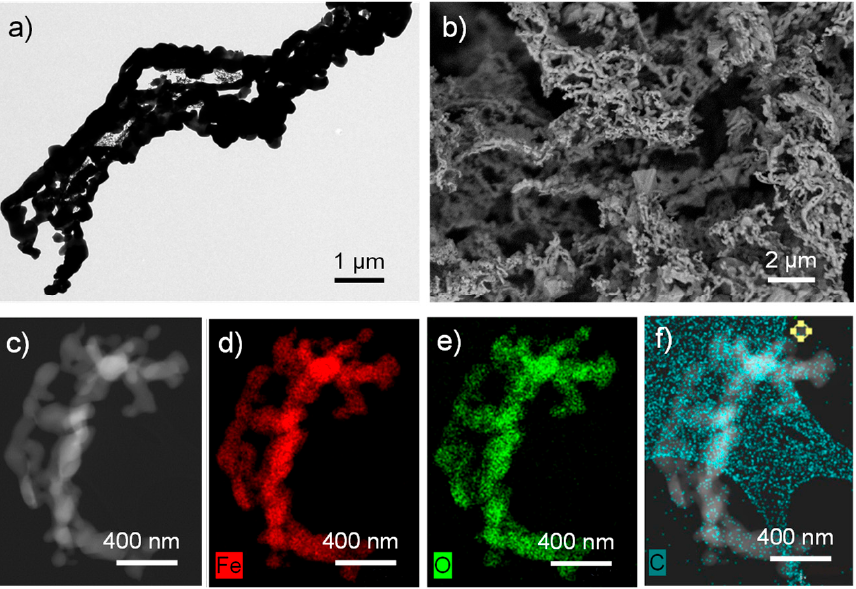
Figure 1. ( a ) BF-TEM image and ( b ) SEM image of the as-synthesized powder of C-Fe 2 O 3 active material. STEM-EDS analysis of the C-Fe 2 O 3 active material: ( c ) High-angle annular dark-field (HAADF)-STEM image and the corresponding EDS maps for ( d ) Fe (K α ), ( e ) O (K), and ( f ) C (K). In panel ( f ), the C map is overlapped with the HAADF-STEM image, to emphasize the region on which the quantitative elemental analysis has been performed (defined by the line linking the yellow dots), suspended on a hole in the carbon film.